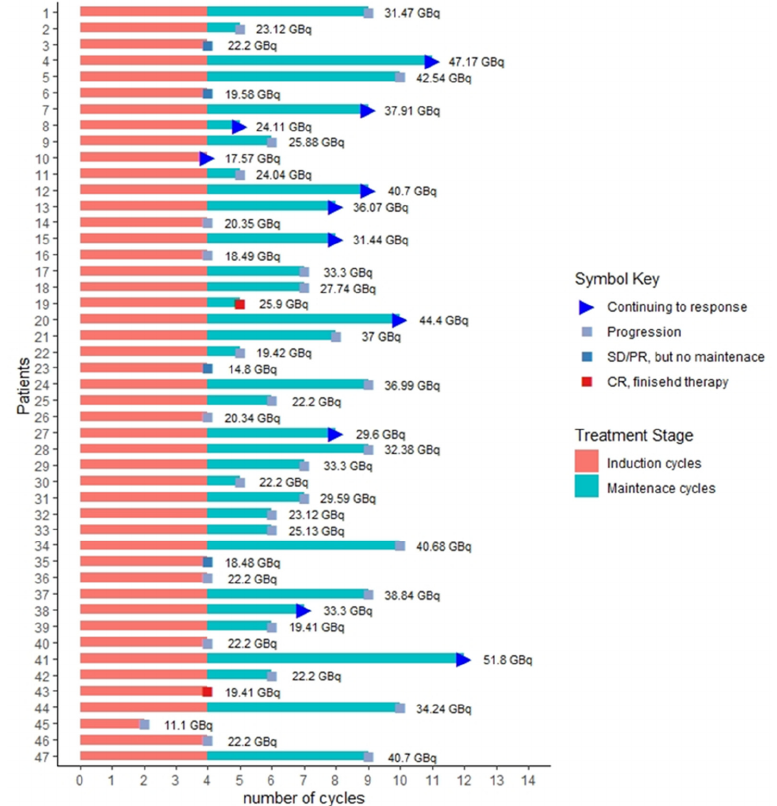
Figure 1. Swimmer plot representing the total number of cycles and cumulative dose for each patient. SD = stable disease. PR = partial response.